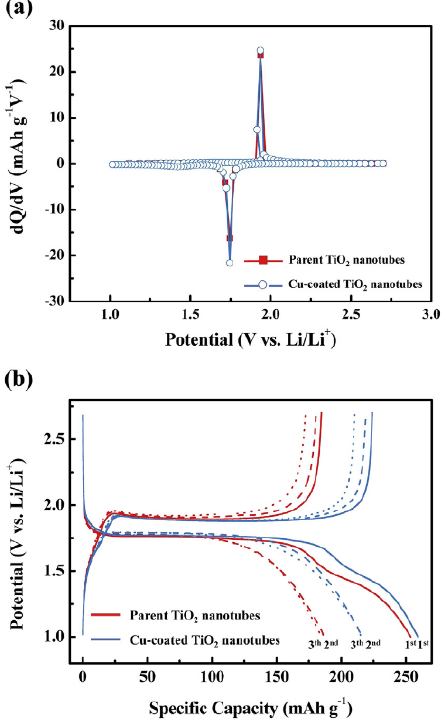
Figure 9. The differential capacity plot (dQ/dV vs. V) corresponding to the first cycle of the parent and Cu-coated TiO 2 NTs at a current density of 50 mA g − 1 is shown as ( a ) differential capacity vs. cell potential curves of parent and Cu-coated anatase-phase TiO 2 NTs at 50 mA g − 1 . ( b ) Discharge–charge curves of the parent and Cu-coated TiO 2 NTs between 2.7 and 1.0 V at a constant current density of 50 mA g − 1 show that the Cu-coated TiO 2 NTs’ Coulombic efficiency was 13.7% higher than that of the parent TiO 2 NTs. The aforementioned findings point to a more pronounced charge transfer response in the Cu-coated TiO 2 NTs during the charge–discharge procedure than in the parent TiO 2 NTs. With permission from Ref. [66]. 2015 Elsevier B.V. All rights